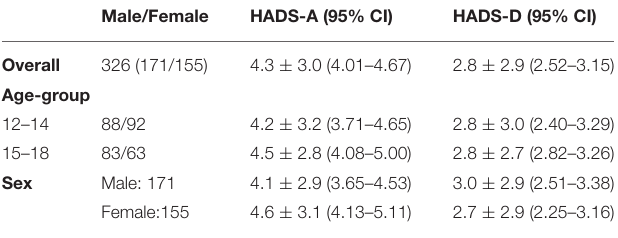
groups (12–14: late childhood; 15–18: late adolescents) and